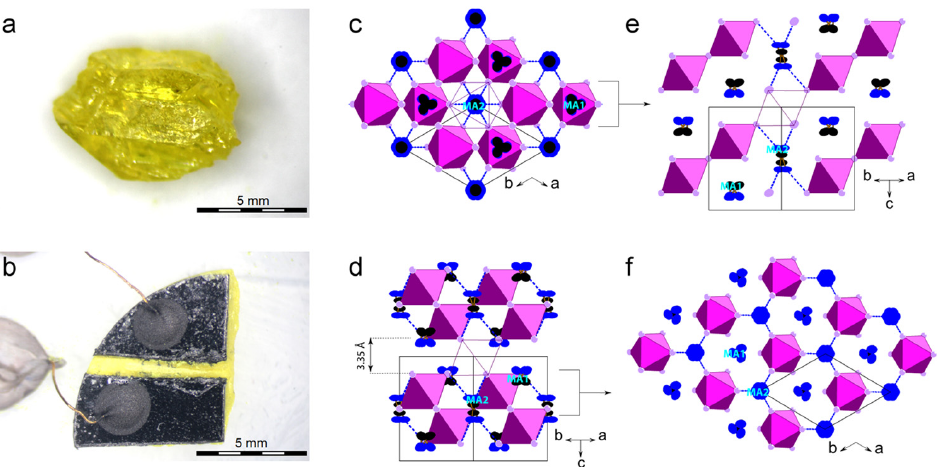
Figure 1. MA 3 Bi 2 Br 9 : ( a ) single crystal, ( b ) powder pressed pellet with carbon paste and contacts attached to it, ( c , d ) the structure projection along the c -axis and the (110)-direction, respectively, ( e ) representative section of the structure parallel to the c -axis, ( f ) structure of one layer normal to the c -axis. Blue dashed lines indicate the donor–acceptor hydrogen bonds of 3.08 Å. Violet lines show the empty Br 6 -octahedron.